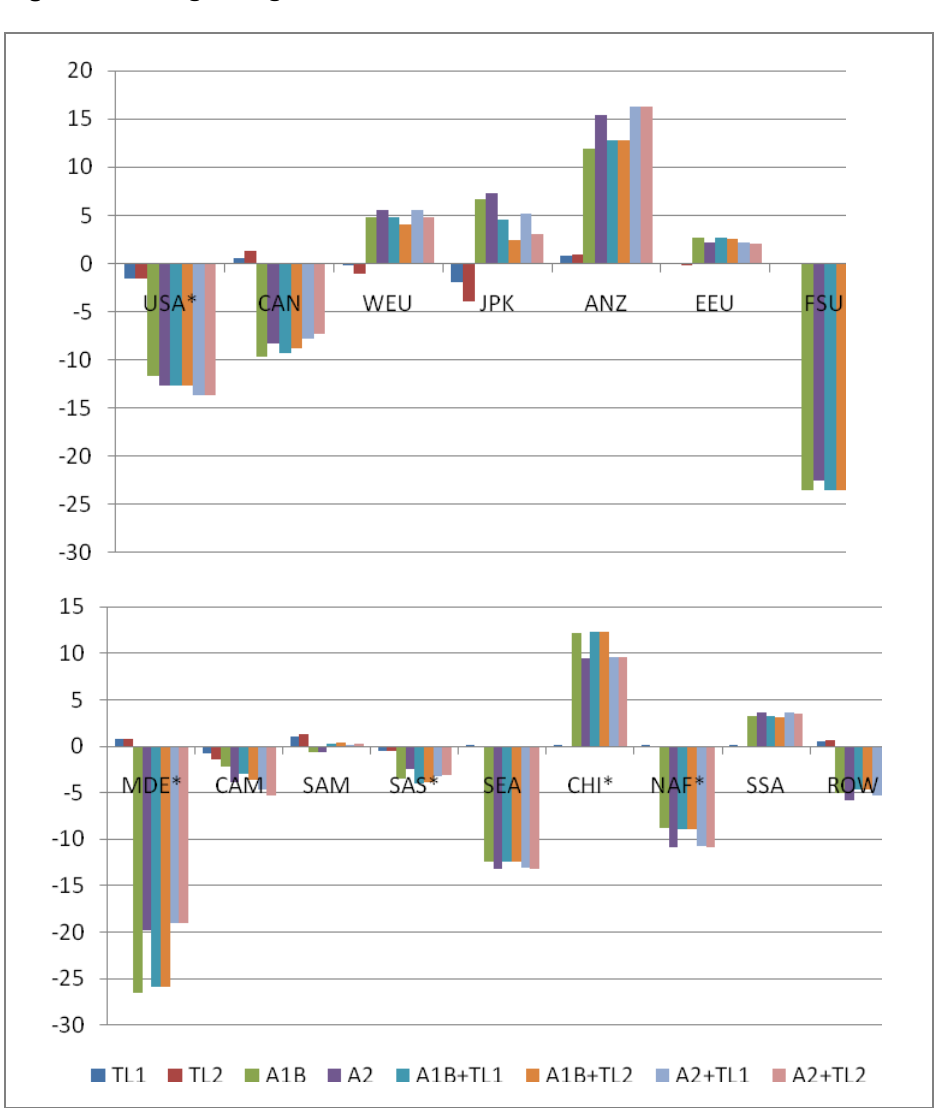
Figure 5. Change in agricultural water use in 2050 relative to baseline (in